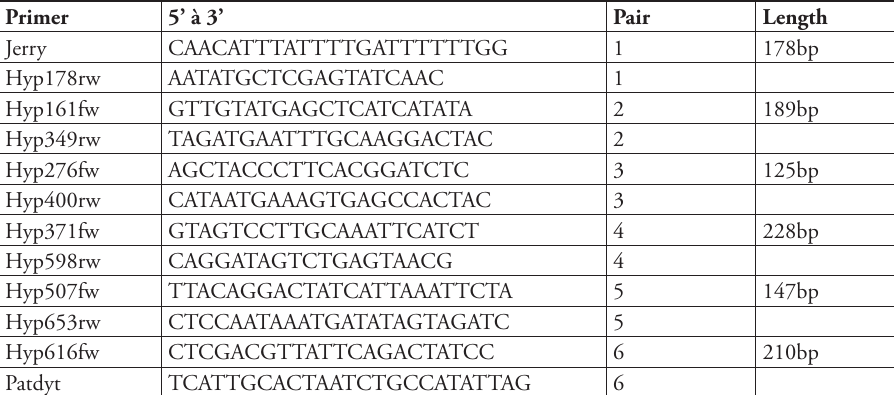
Table 2. Newly designed primers (apart from Jerry and PatDyt) used to amplify 825bp of CO1 in 6 overlapping fragments from 11-25 years old, dry-pinned, Hyphydrus specimens. Primer 5’ à 3’ Pair